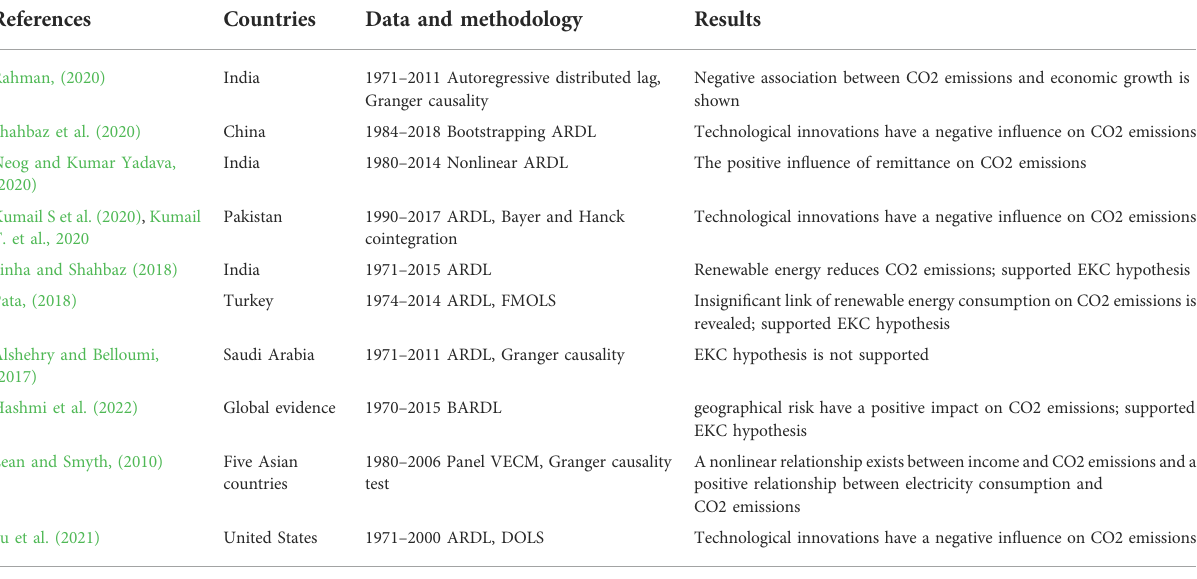
TABLE 1 Summary of the literature review.